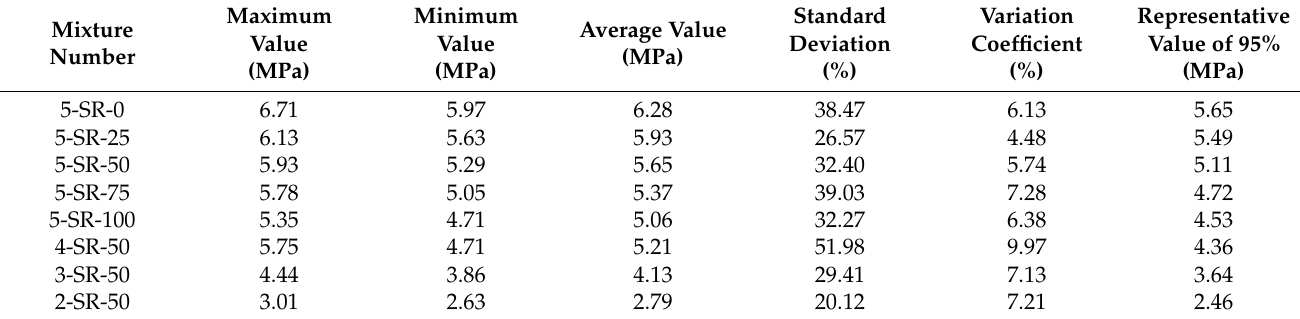
Table 6. Calculation results of strength representative value of 95% guarantee rate of after 7 days.